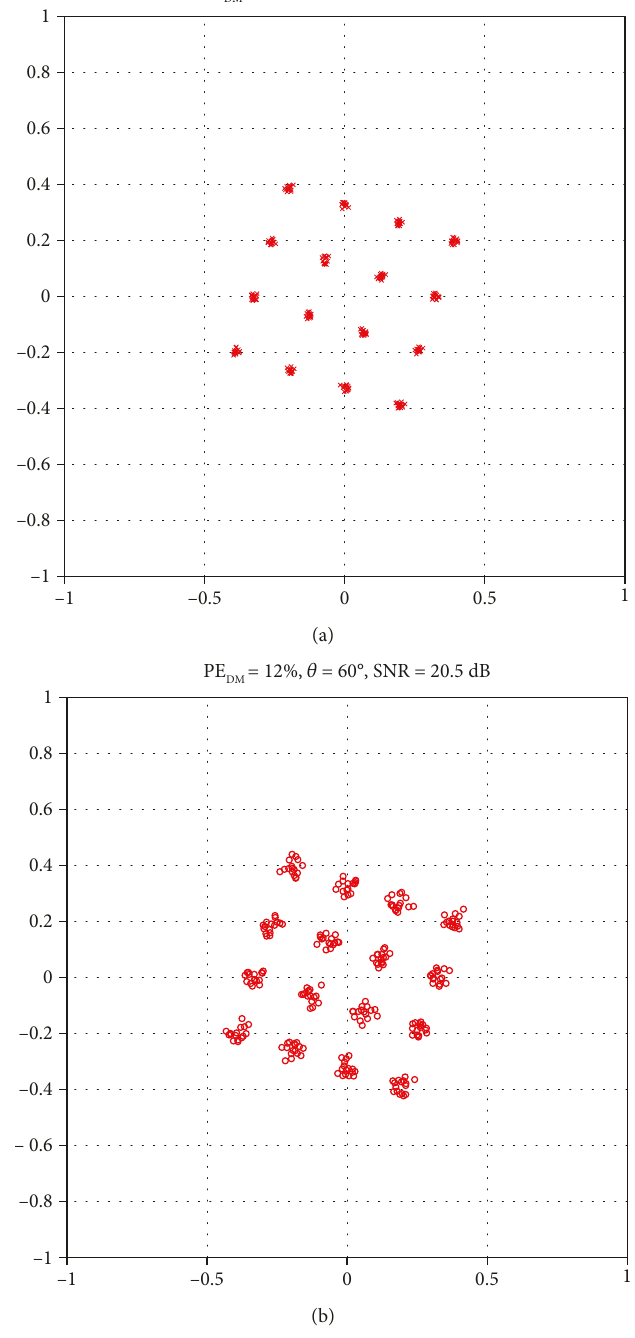
PE = 50% . (b) PE = 12% DM DM